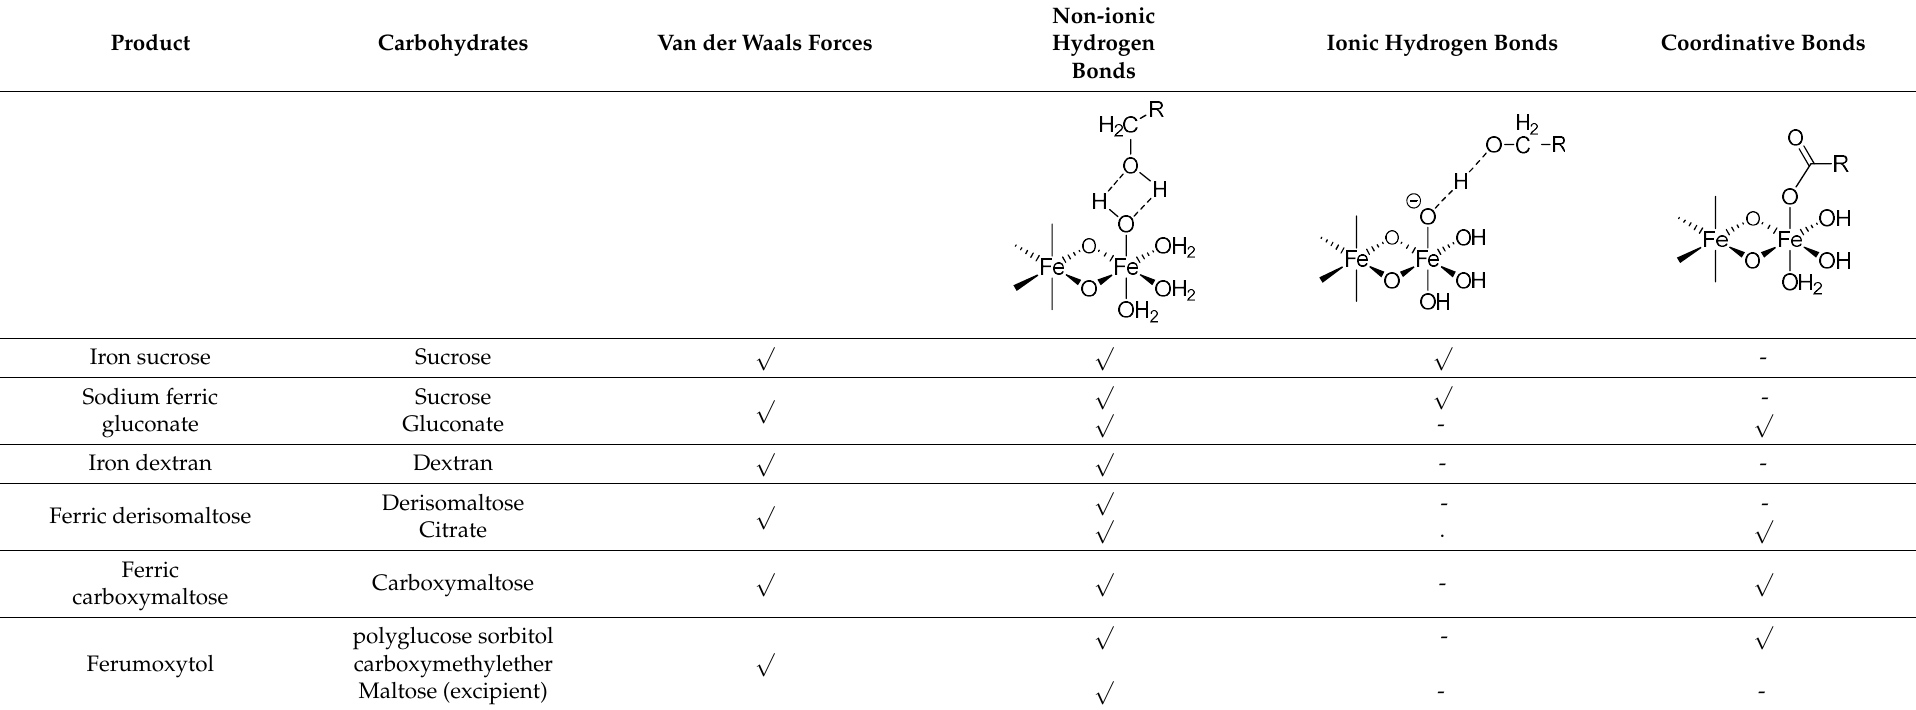
Table 3. Types of bonds present in the iron carbohydrate preparations.